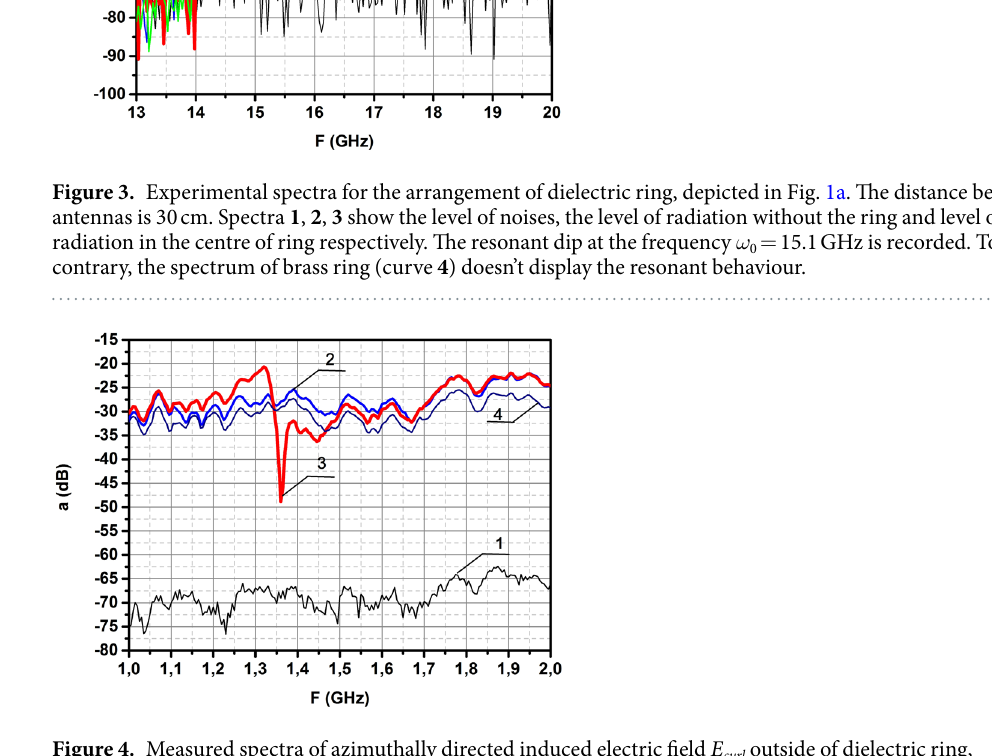
Figure 4. Measured spectra of azimuthally directed induced electric field E curl outside of dielectric ring, depicted in Fig. 1b. The distance between antenna and probe is 60 cm. Spectra 1, 2, 3 show the level of noises, the level of radiation without the ring and the level of radiation in the centre of ring respectively. The resonant dip at the frequency ω 0 = 1.36 GHz is recorded. To the contrary, the spectra of brass ring (curve 4) doesn’t display the resonant